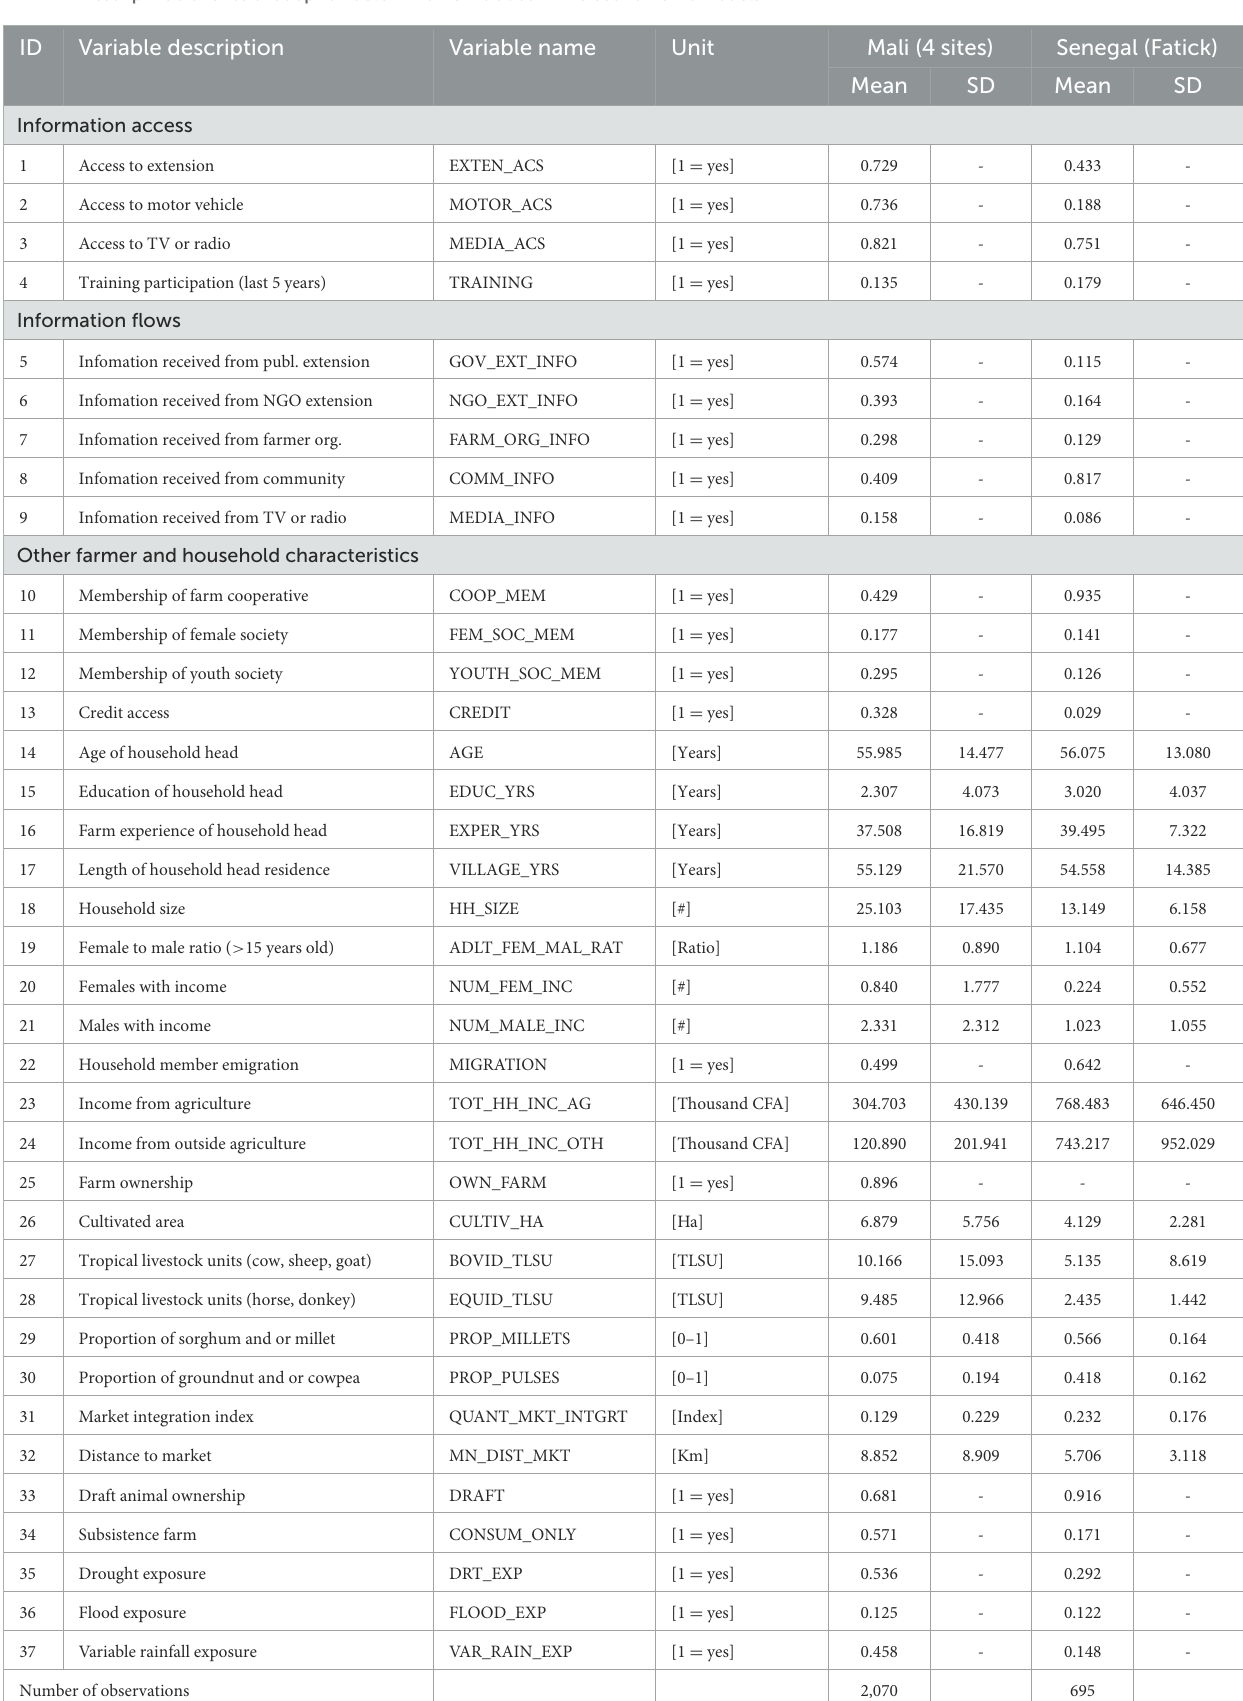
TABLE 2 Descriptive statistics of adoption determinants included in the econometric